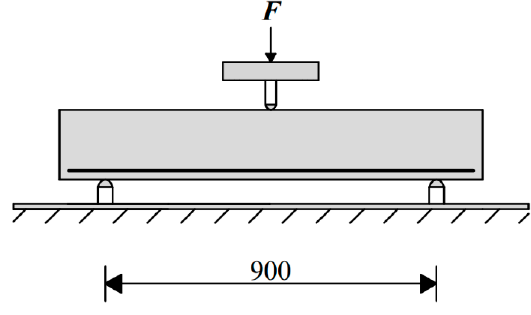
Figure 8. Reinforced concrete beam without transverse reinforcement—scheme of the test.